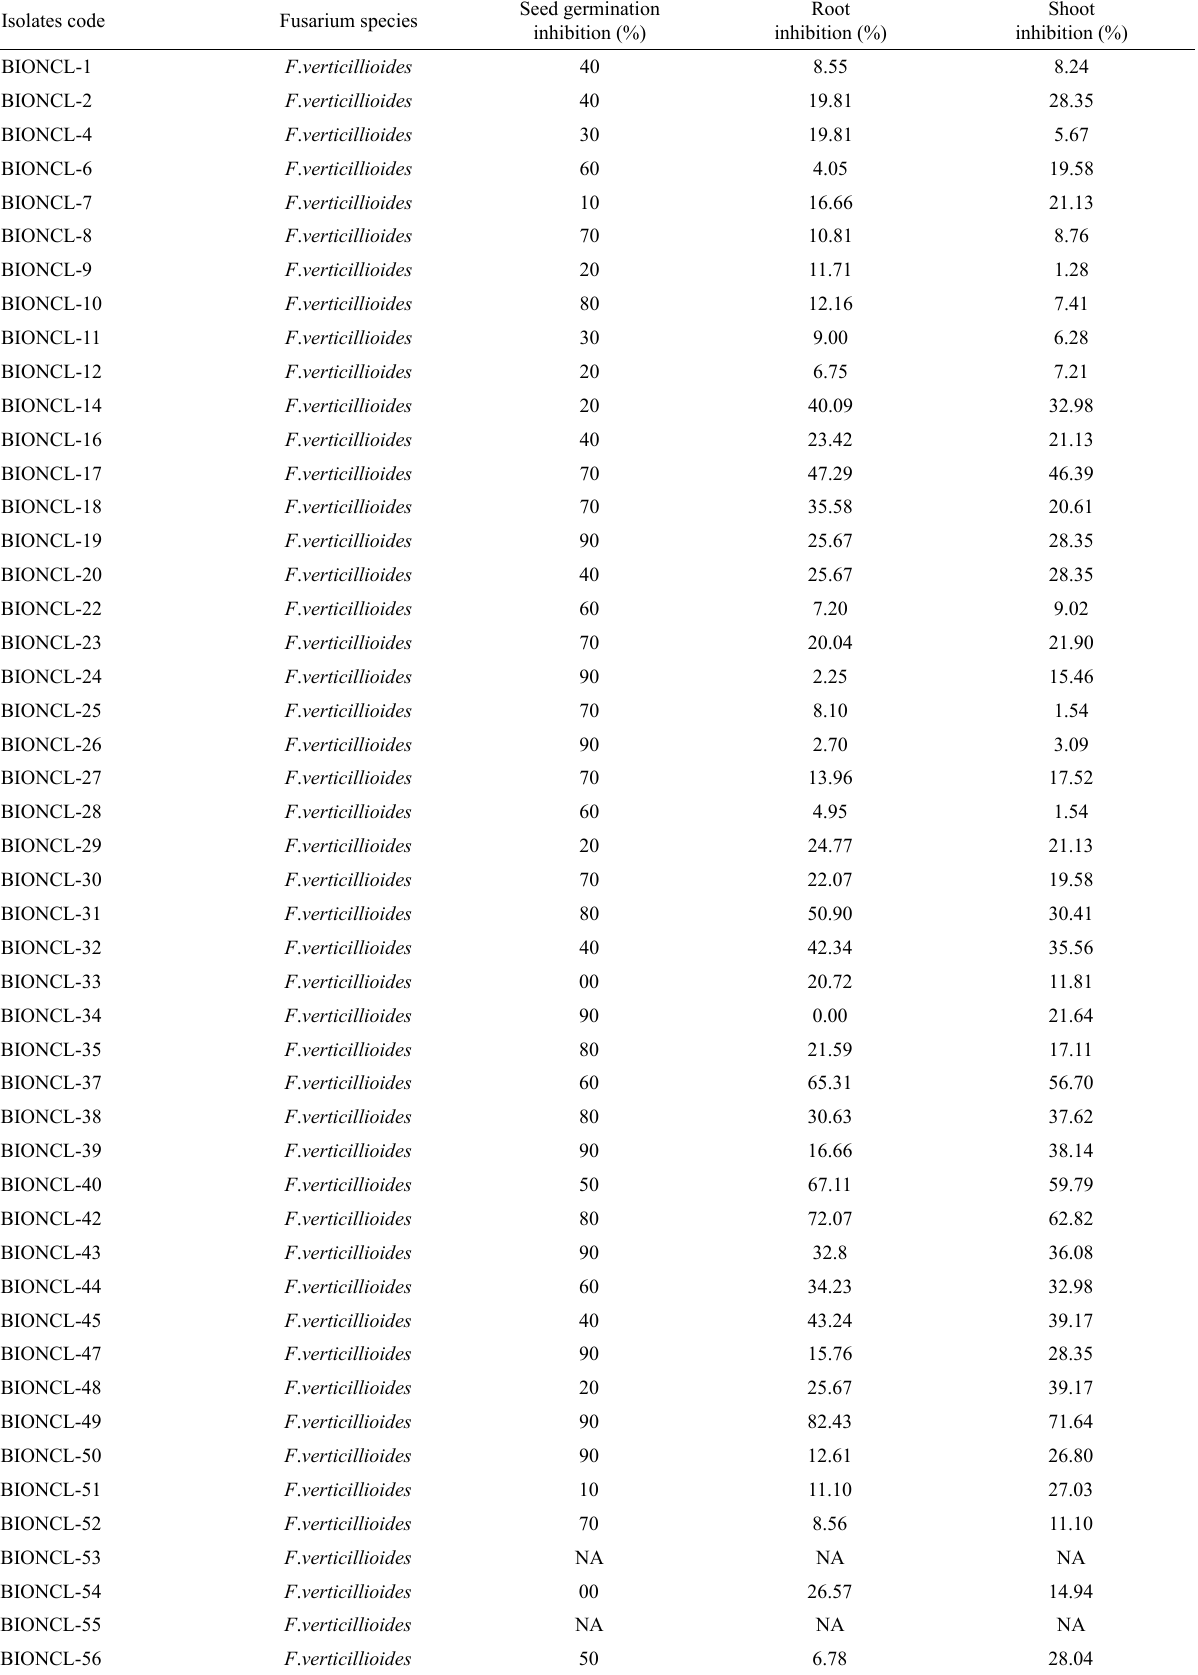
Table 1 – In-vitro effect of Fumonisin B1 producing Fusarium verticillioides on growth of maize grains. Isolates